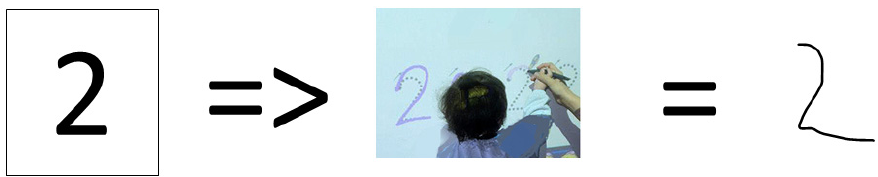
Figure 3. Process for the presentation of a number, representation by the preschool children, and interpretation of the recognition system.